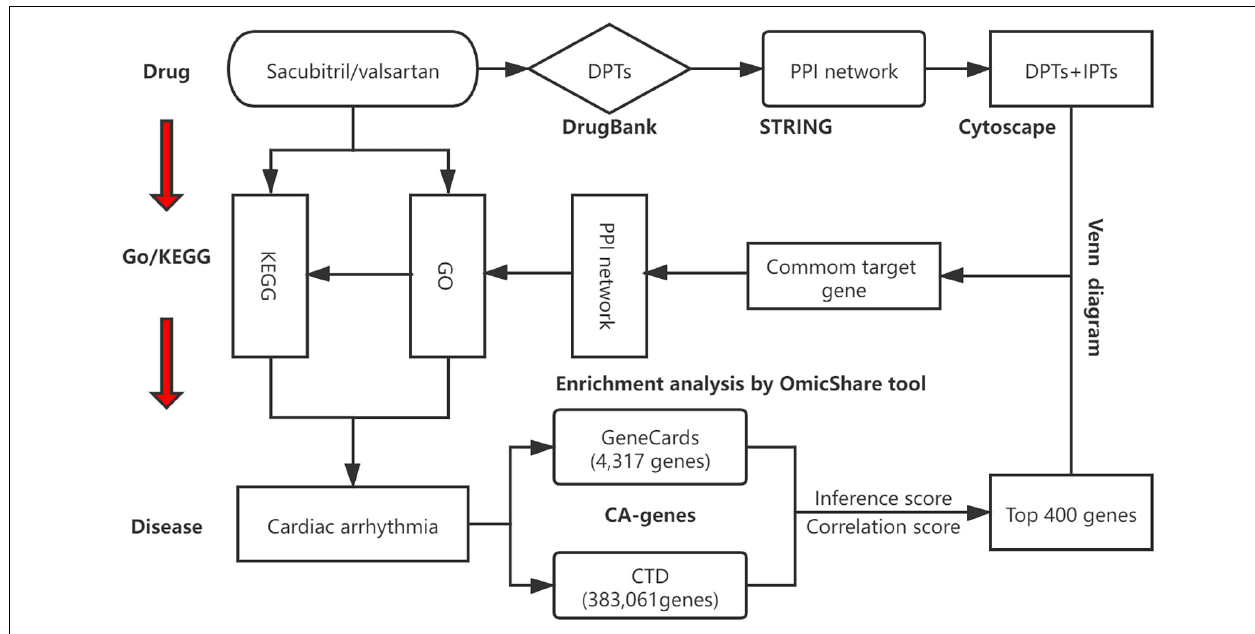
FIGURE 1 | A schematic diagram showing the network pharmacological method for identifying targets, PPI network, biological processes, and key pathways of SV acting on cardiac arrhythmia (CA). All known targets of Sacubitril/valsartan (SV) and CA were obtained through online databases. Anti-arrhythmia targets of SV were identified. After constructing a protein-protein interaction (PPI) network and determining the potential targets of SV concerning CA, gene ontology (GO) and Kyoto Encyclopedia of Genes and Genomes (KEGG) enrichment analyses were carried out. Finally, the SV-GO-KEGG-CA network was generated. CTD: comparative toxicology genomics